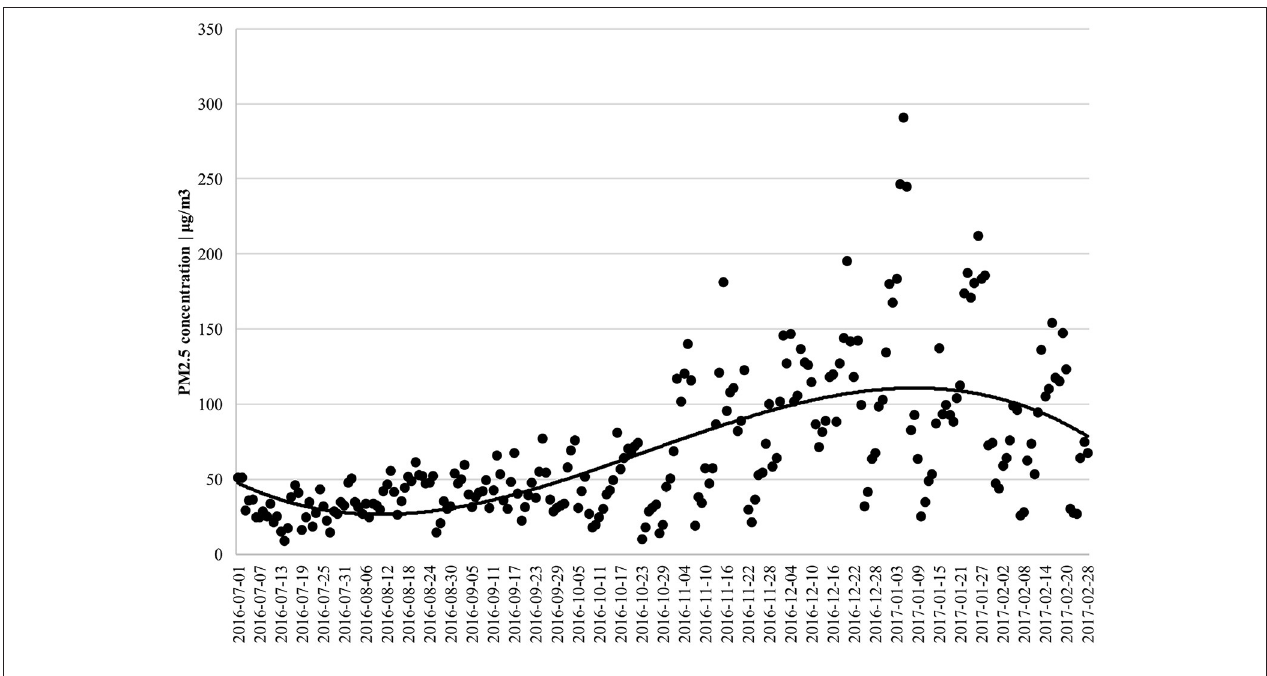
FIGURE 3 | Time trend of PM 2.5 in sample city.